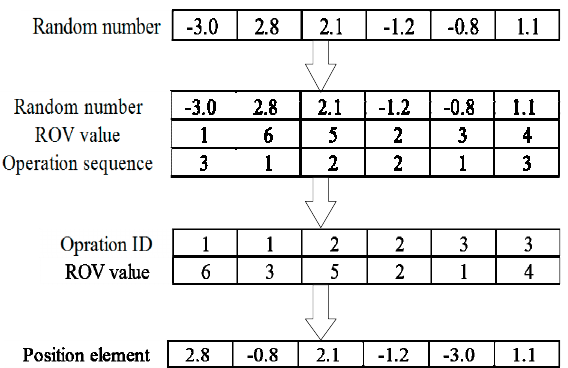
Figure 3. The conversion process from operation sequence to individual position vector.